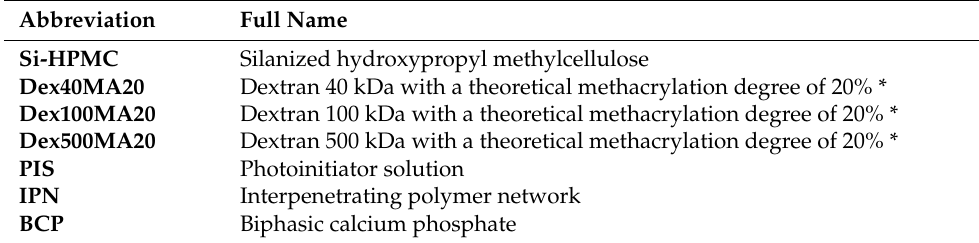
Table 1. The polymers and materials used in this